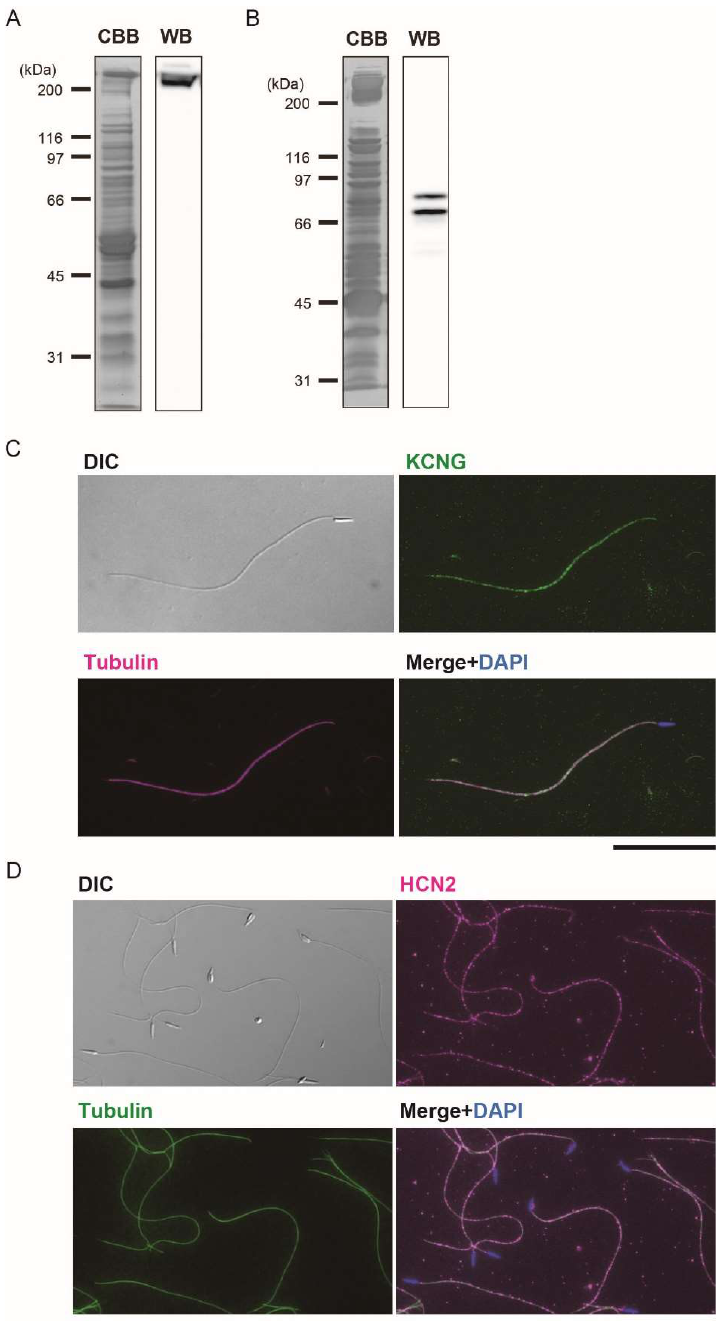
Figure 5. Western blot and immunolocalization analysis of the Ci-tetraKCNG and Ci-HCN2 in Ciona sperm. ( A ) Western blot of whole sperm protein with the antibody against the Ci-tetraKCNG. CBB- stained pattern of whole sperm proteins (Left) and corresponding immunoblots (Right) are shown. ( B ) Immunolocalization with the antibody against the Ci-tetraKCNG. The differential interference contrast (DIC) image, Ci-tetraKCNG (green), β-tubulin-Cy3 (magenta), and the merged image with DAPI (blue) are shown. Scale bar: 20 µm. ( C ) Western blot of Triton X-100 soluble sperm protein with the antibody against the Ci-HCN2. CBB-stained pattern of whole sperm proteins (Left) and corresponding immunoblot (Right) are shown. ( D ) Immunolocalization with the antibody against the HCN2. The differential interference contrast (DIC) image, Ci-HCN2 (magenta), acetylated α-tubulin (green) and the merged image with DAPI (blue) are shown. No fluorescence signal was detected in flagella in the control sperm treated by nonimmune serum from mouse. Typical images from at least three experiments are shown. Scale bar: 20 µ